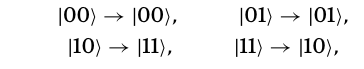
lapped at the interferometer using a polarization switching electro-optic modulator (EOM) and a 1-km delay fi ber. Before the two-photon interference at the fi rst PPBS, two half-wave plates (HWPs) are employed to prepare the input state of the control and target qubits. Two more PPBSs and HWPs are used after the interference to complete the CNOT gate operation. The output state is measured by a polarization-sensitive detection setup consisting of HWPs, polarization beam splitters (PBSs), and SPCMs (c 0,1 and t 0,1